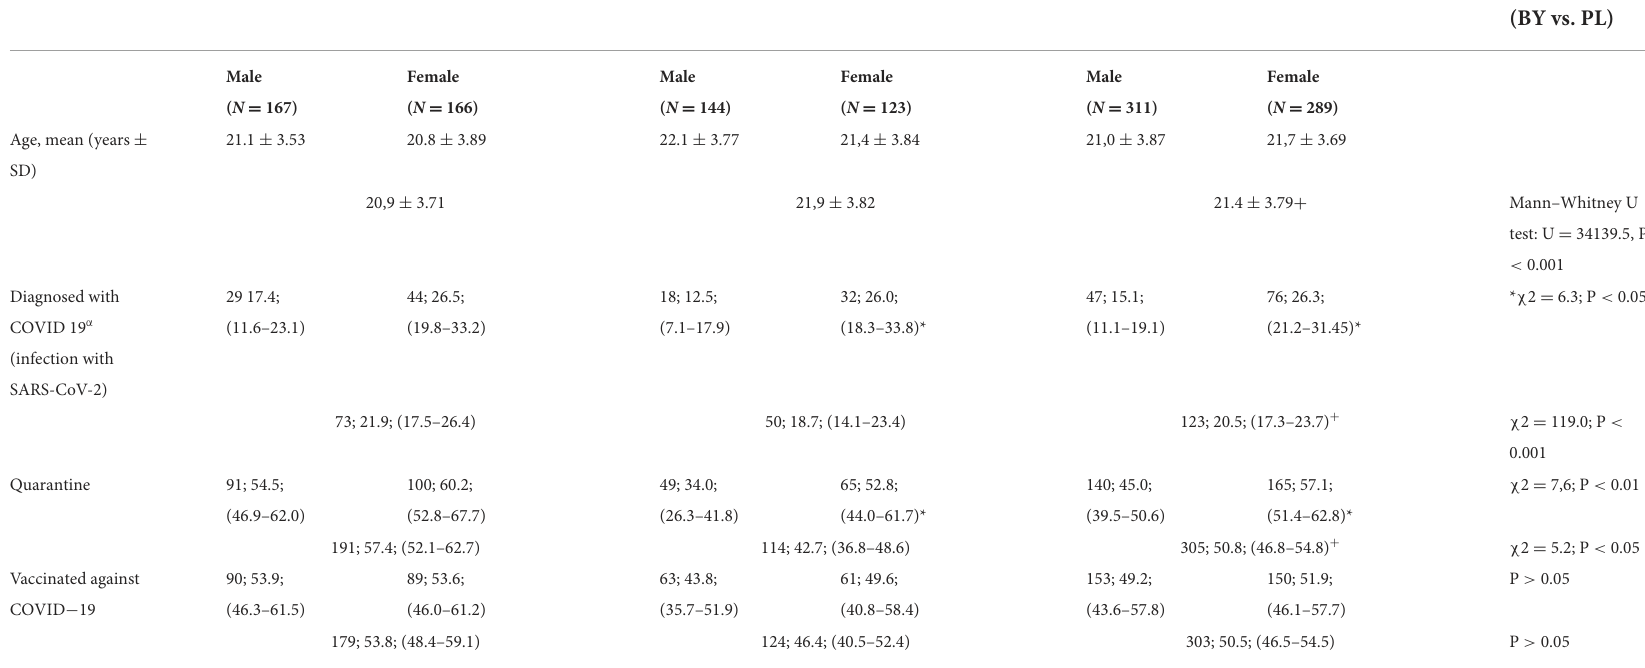
TABLE 1 Cohort demographics, COVID-19 exposure and differences between Belarus and Poland. Variables ( n , Belarus, N = 333 (55.5%) (BY) Poland, N = 267 (44.5%) (PL) Total sample N = 600 (100%) χ 2 for country %, 95%CI)